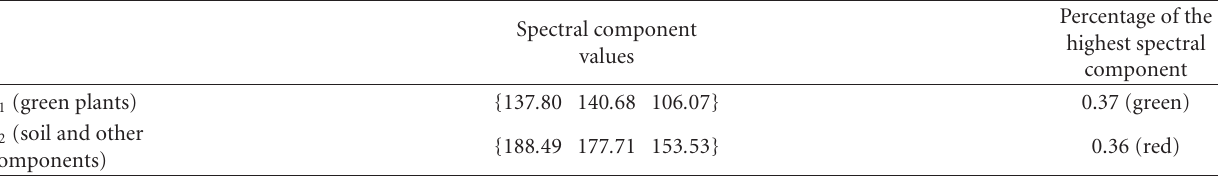
Table 1: Percentage of the green spectral component for green plants and for other components (soil, debris, stones).